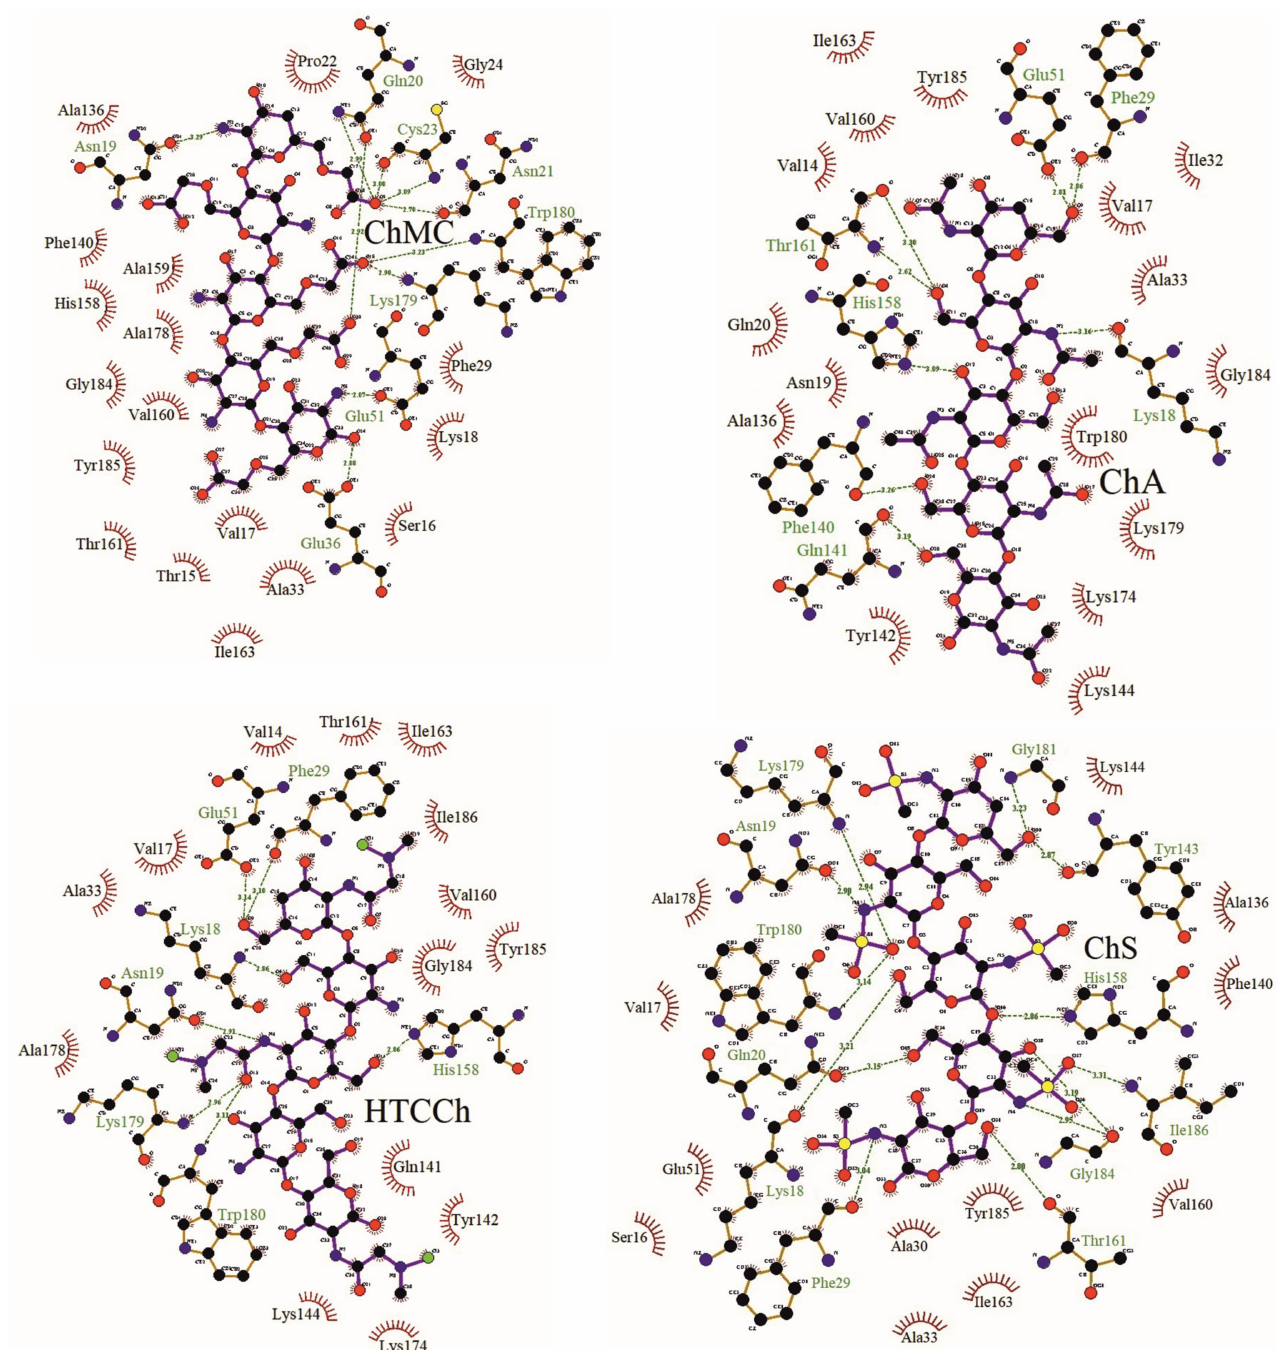
Figure 3. Molecular docking results. Bonds (indicated by dashed lines) and interactions between molecules of bromelain and chitosan derivatives: ChMC, HTCCh, ChS, and ChA. To study the hydrogen bonding between bromelain and chitosan derivatives in more detail, we analyzed the FTIR spectra of immobilized samples, including the 3000–3600 cm − 1 region (Figure